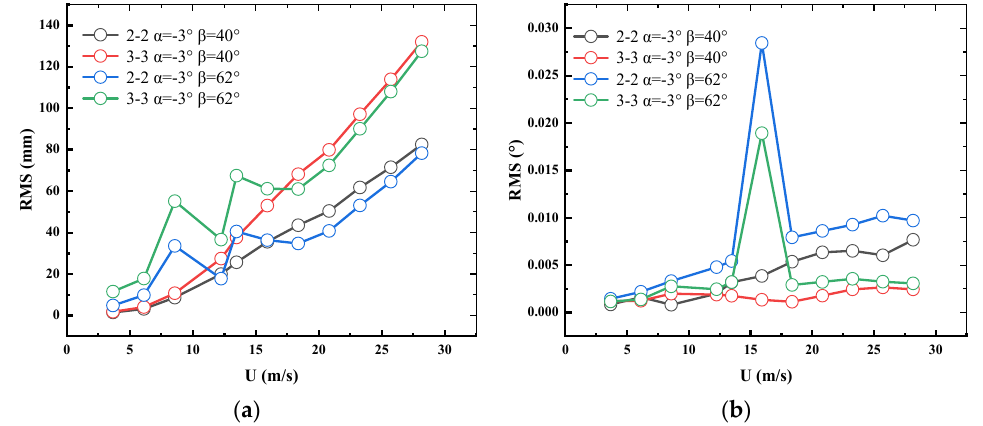
Figure 18. The root mean square (RMS) value of the displacement of mid-span and closure of the service state in uniform wind. ( a ) Vertical; ( b ) torsional.